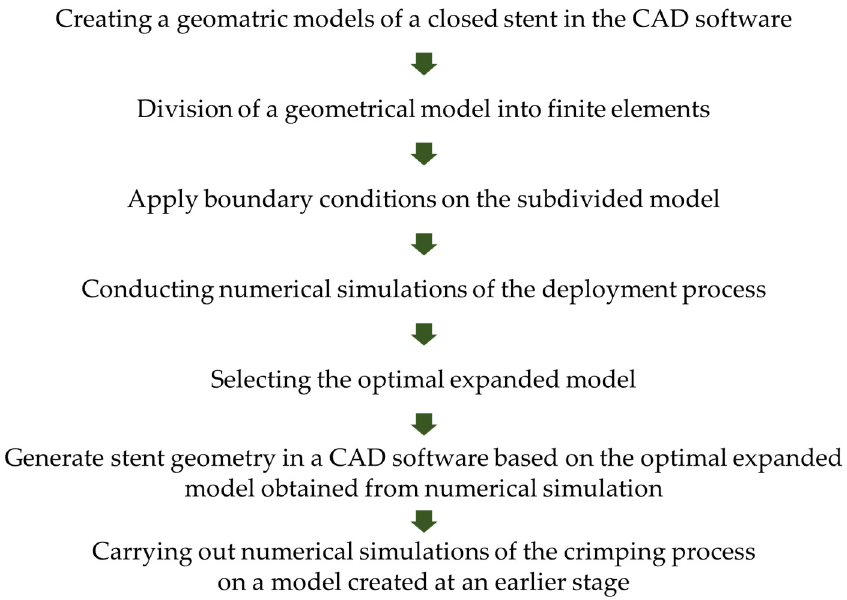
Figure 1. Diagram of two-step modeling in a given case.